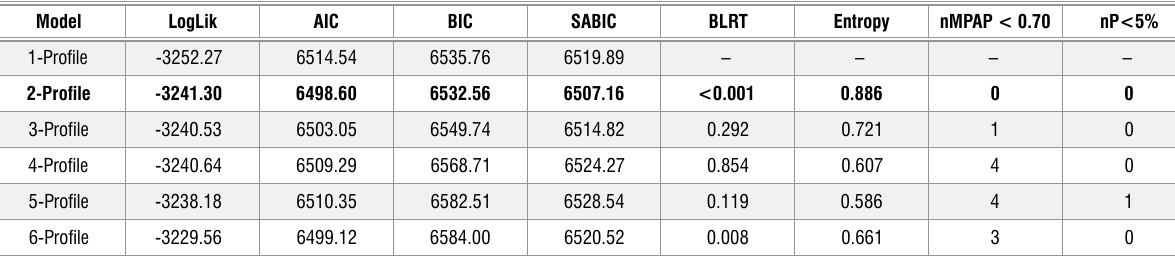
Table 2: Fit indices for forgiveness of partner latent profile models